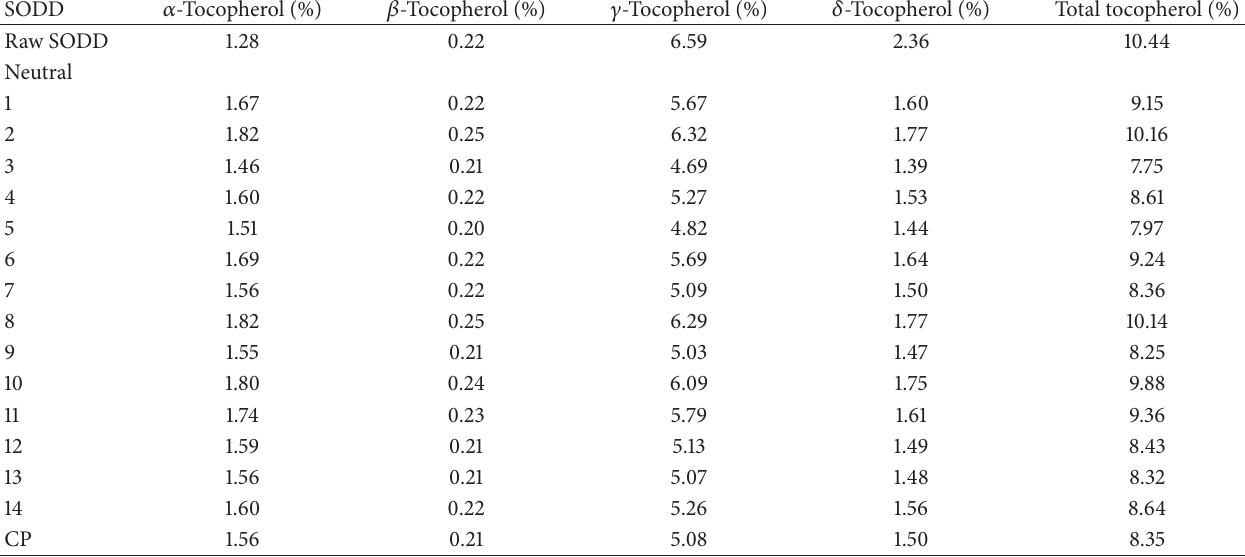
Table 4: Tocopherol content in raw and neutralized SODD obtained in the second experimental design.